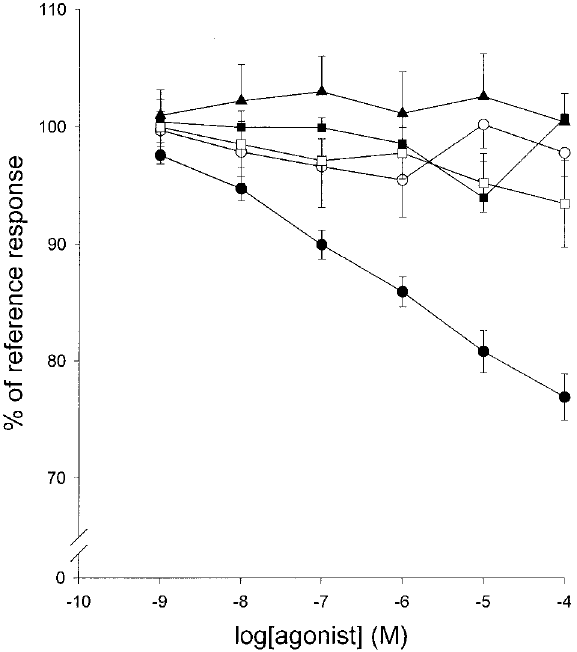
FIG. 3. The effect of L -glutamate on KCl-induced contractions ( d ), and in the presence of TTX ( s ). The responses are mean ±SE ( n = 6) and are plotted as a percentage of reference response before the exposure to L -glutamate. p < 0.05, ** p < 0.01, *** p < 0.001, paired t -test.